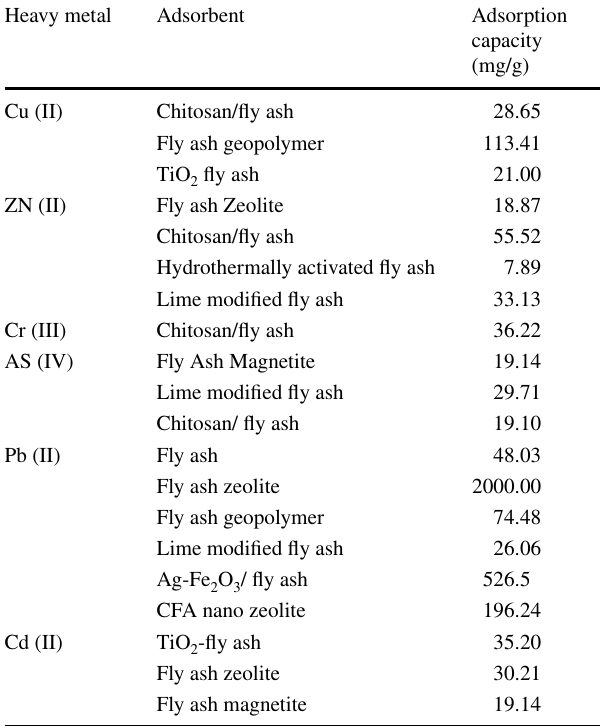
Fig. 18 SEM micrograph of a Fly ash and b Activated fly ash (Xiyili et al. 2017) Table 9 Adsorption capacities for Cu, Cr, Zn, Cd, Pb and As onto FA and modified or transformed Fly ash (FA) (Mushtaq et al.